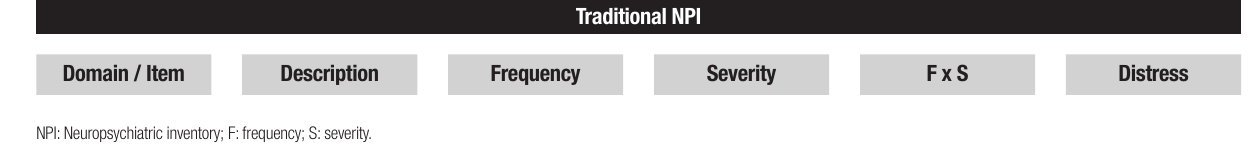
Figure 1. Structure of traditional Neuropsychiatric